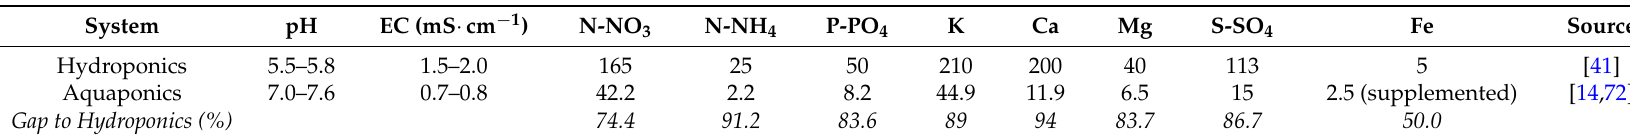
Table 4. Suggested hydroponic nutrient solution (ppm) vs. observed aquaponic nutrient solution (ppm) for lettuce, and the percentage difference of aquaponics with respect to optimal hydroponic